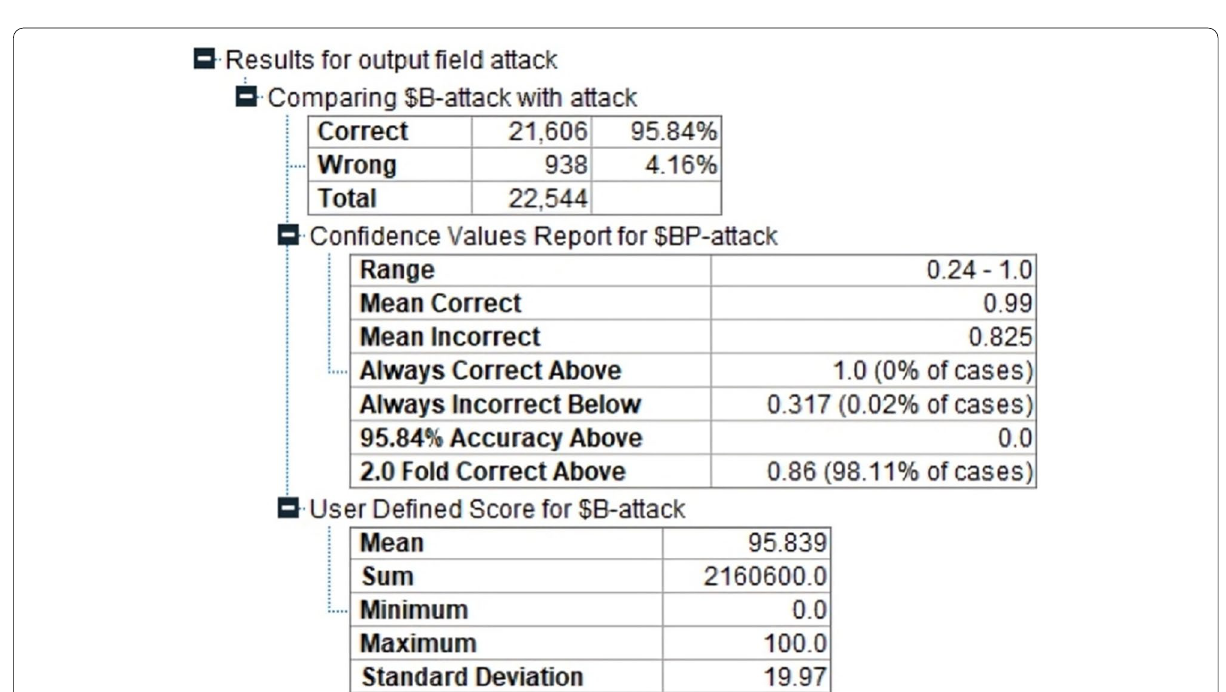
Fig. 15 accuracy level in Bayesian Network